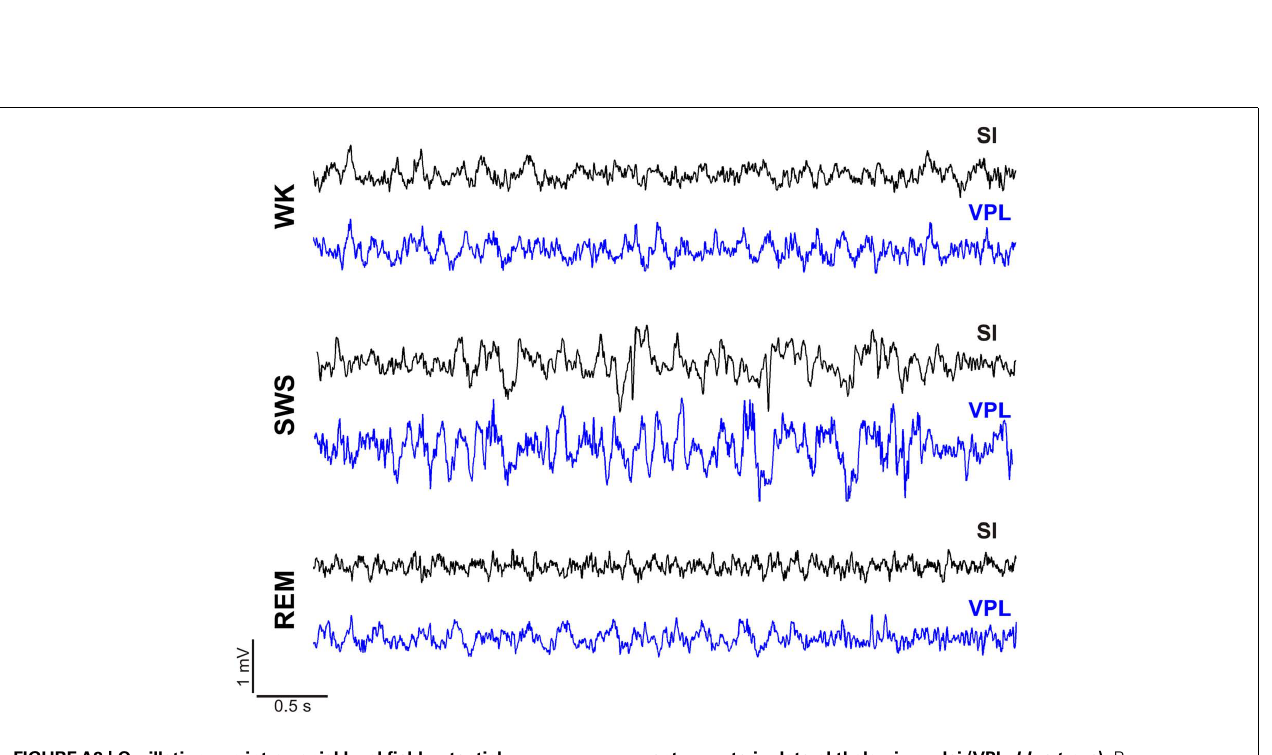
FIGUREA2 | Oscillations on intracranial local field potentials (LFPs) recorded in one session during the dark phase (SHAM-baseline period) simultaneously in the primary somatosensory cortex (SI, black trace ) and in the